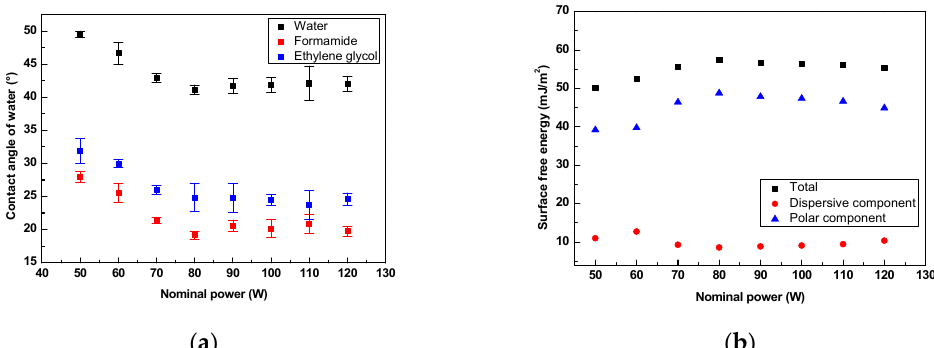
Figure 1. ( a ) Contact angle and ( b ) surface free energy as a function of nominal power for polyurethane (PU) treated using air plasma (60 s).